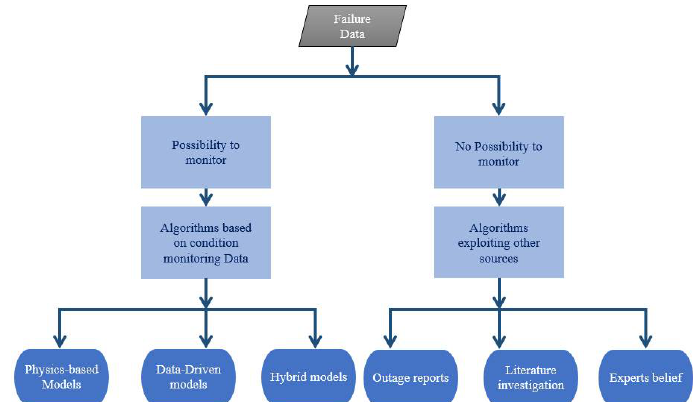
Figure 12. PHM methods [70] .